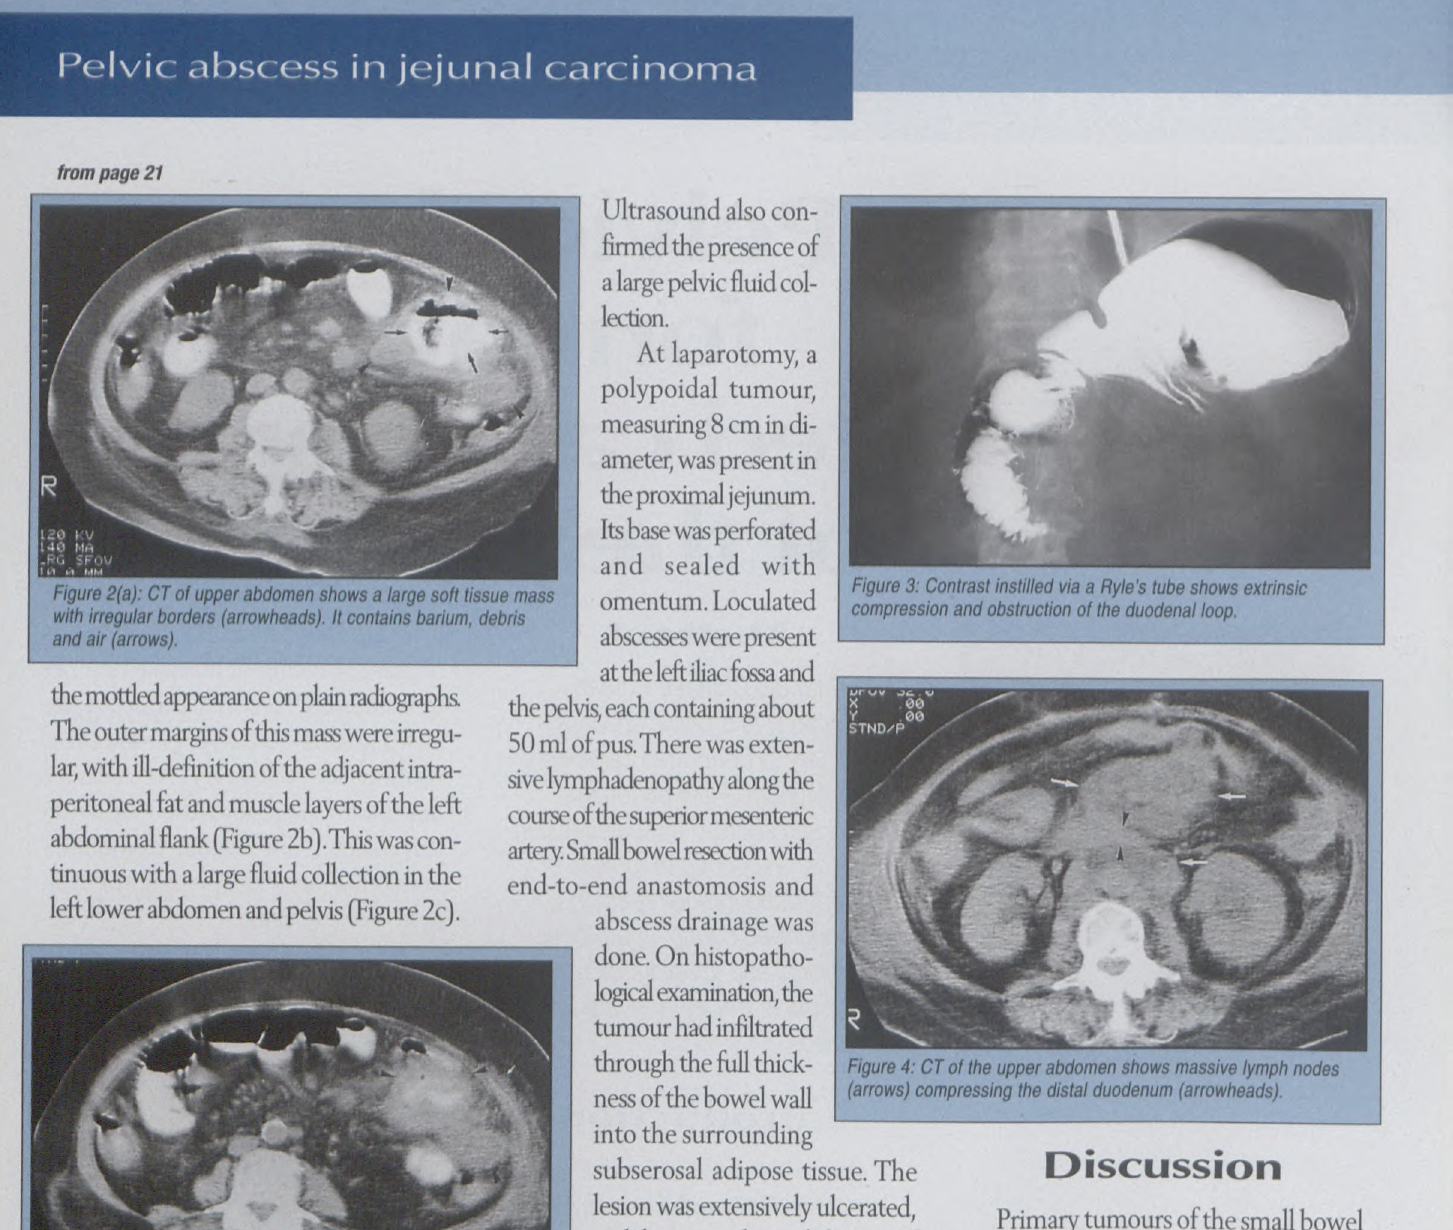
Figure 4: CT of the upper abdomen shows massive lymph nodes (arrows) compressing the distal duodenum